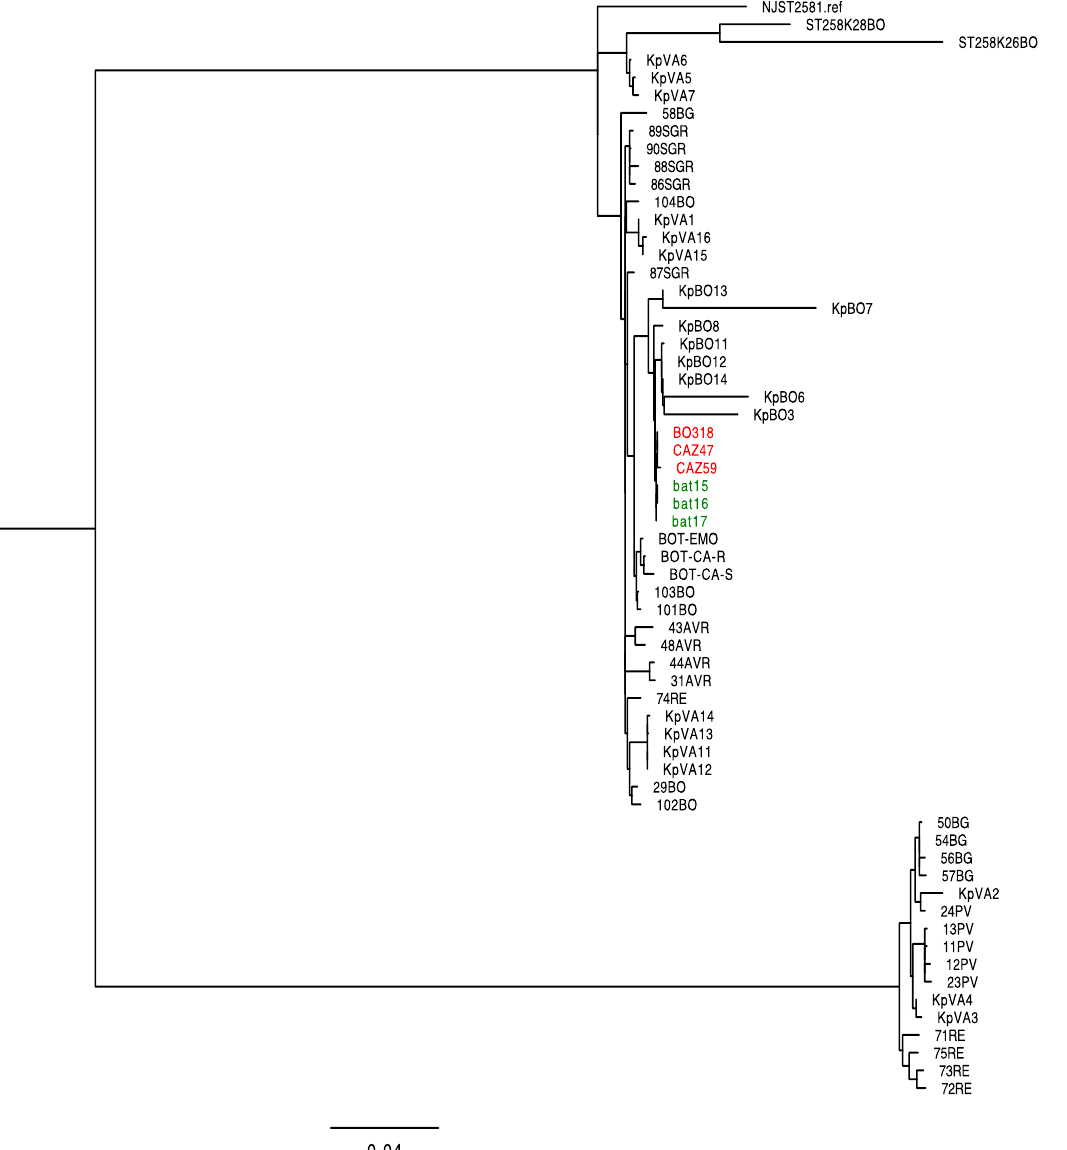
Figure 3. Phylogenetic tree of KPC-producing K. pneumoniae (KPC-Kp) included in this study and genomes of Italian isolates. Strains described in this study are highlighted in green, while KPC-Kp strains described in a previous study [20] are highlighted in red.